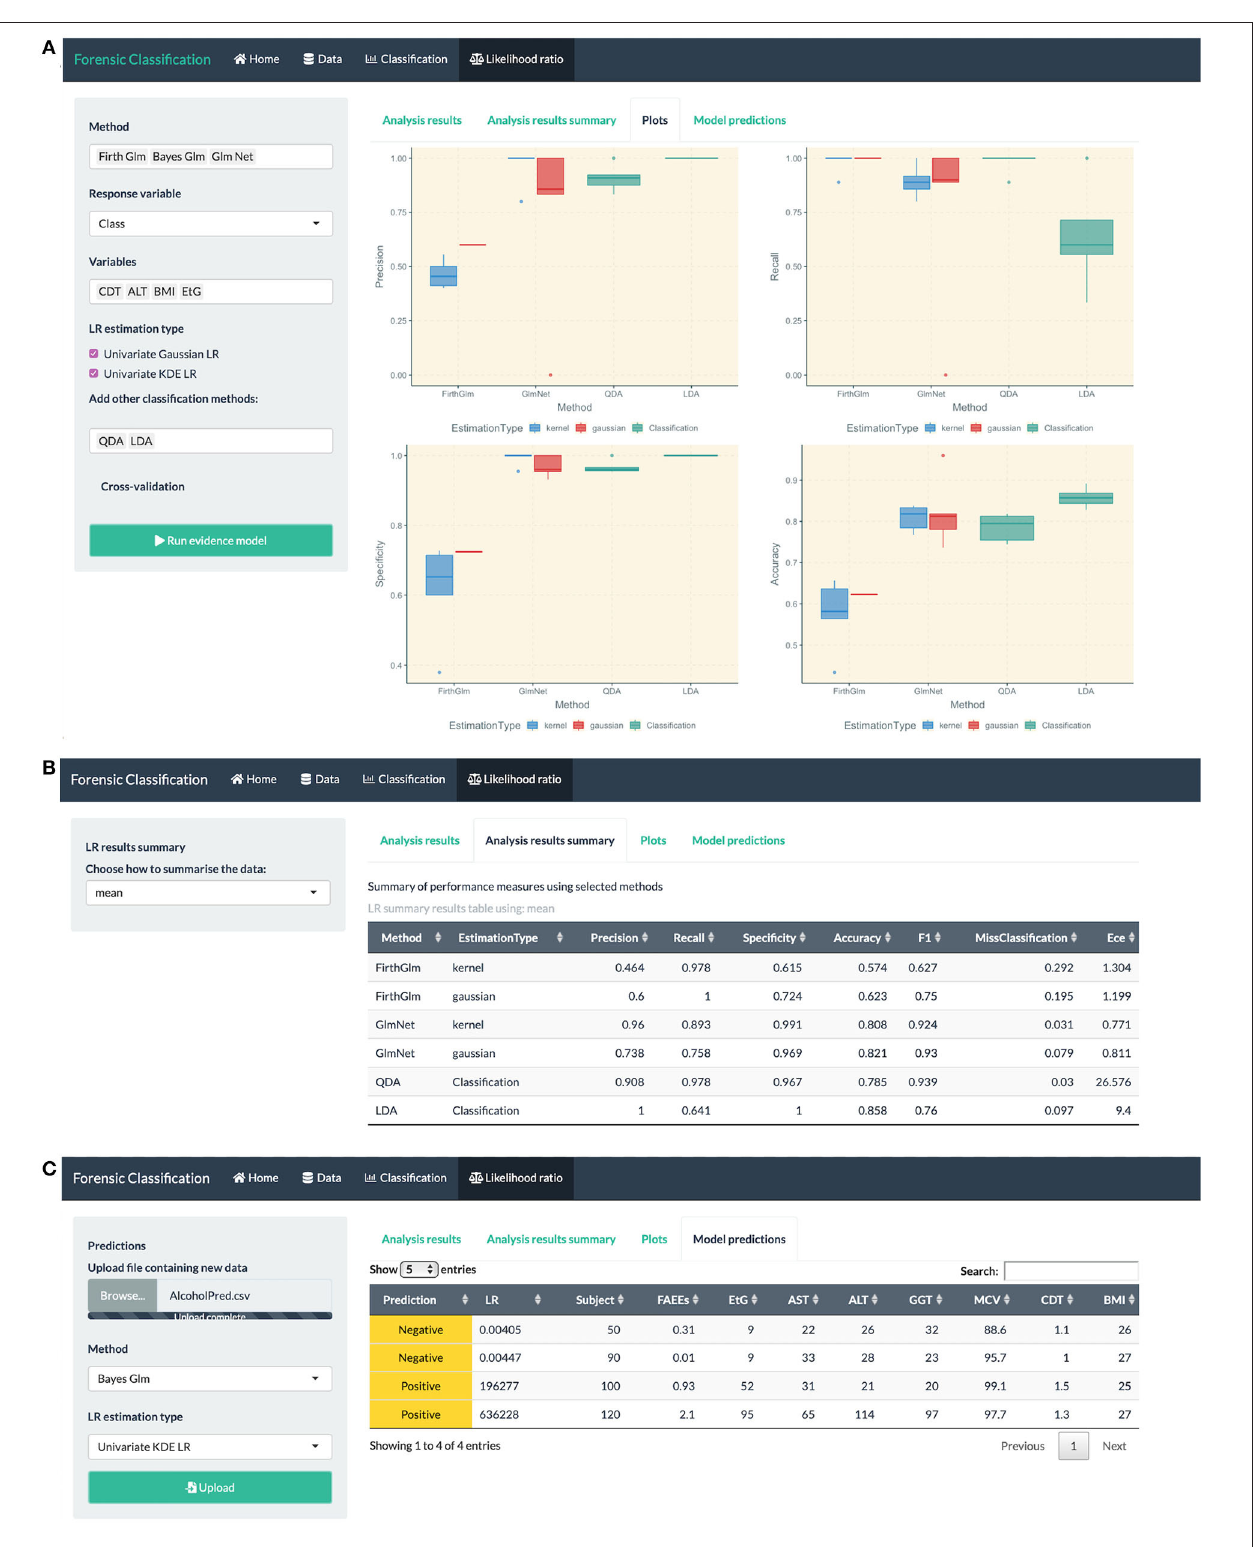
FIGURE 6 | R Shiny app: “Likelihood ratio” tab screenshots, showing in (A) model comparison based on LR combination methods (Firth and GLM-NET) and regular classification methods such as LDA and QDA, in (B) summary of performance measures for method comparison, in (C) prediction table based on the Bayes GLM method with scores estimated using KDE, including the predicted class and LR for each observation in the uploaded dataset.